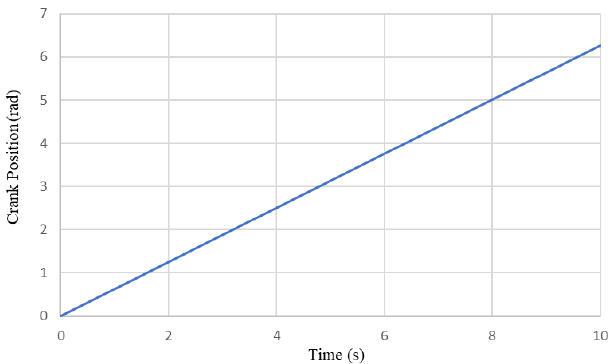
Figure 5. Crank position with a constant velocity.